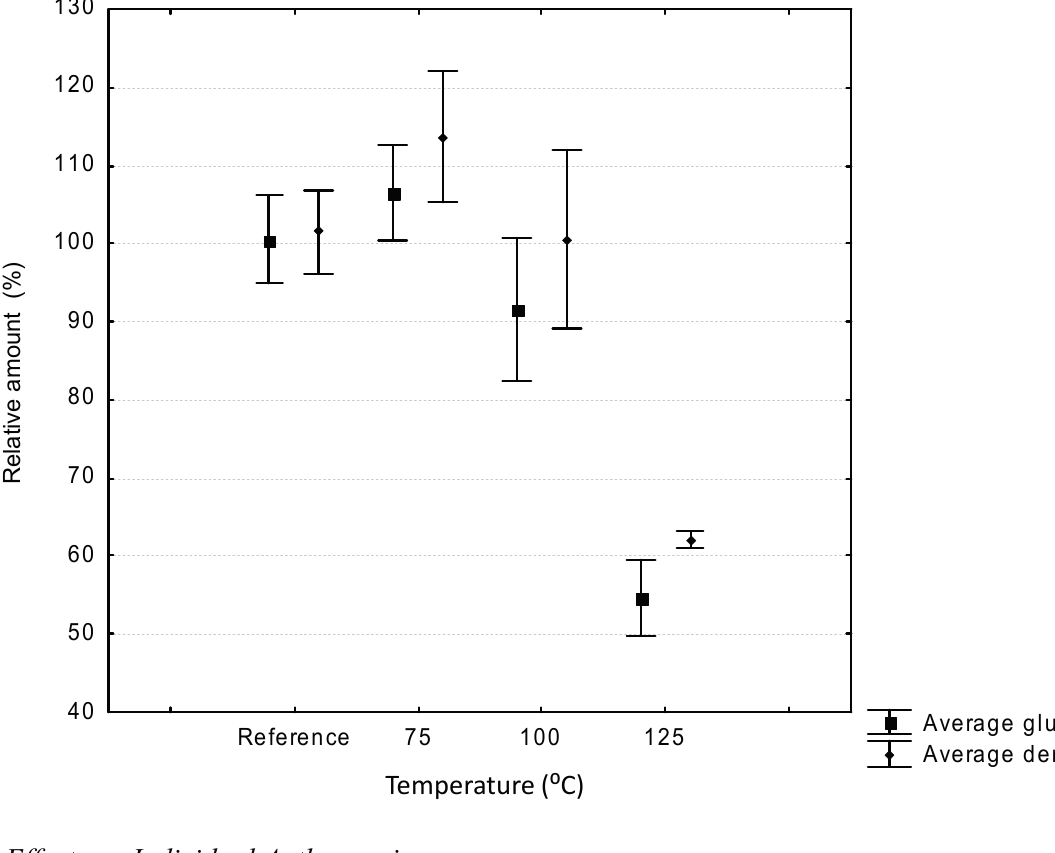
Figure 2. Average recoveries (mean ± standard deviation) of anthocyanins at different working temperatures (75, 100 and 125 °C) and reference sample in the pressurized liquid extraction